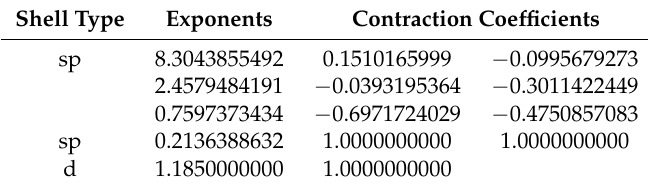
Table A10. Parameters of the cc-DZVP basis set of Oxygen. Parameters taken from [80].